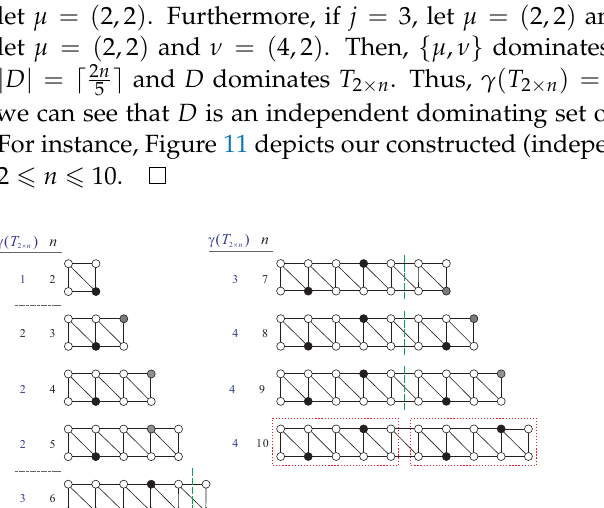
Figure 11. γ ( T 2 × n ) = γ ind ( T 2 × n ) = (cid:100) 2 n minimum (independent) dominating set of T 2 × n